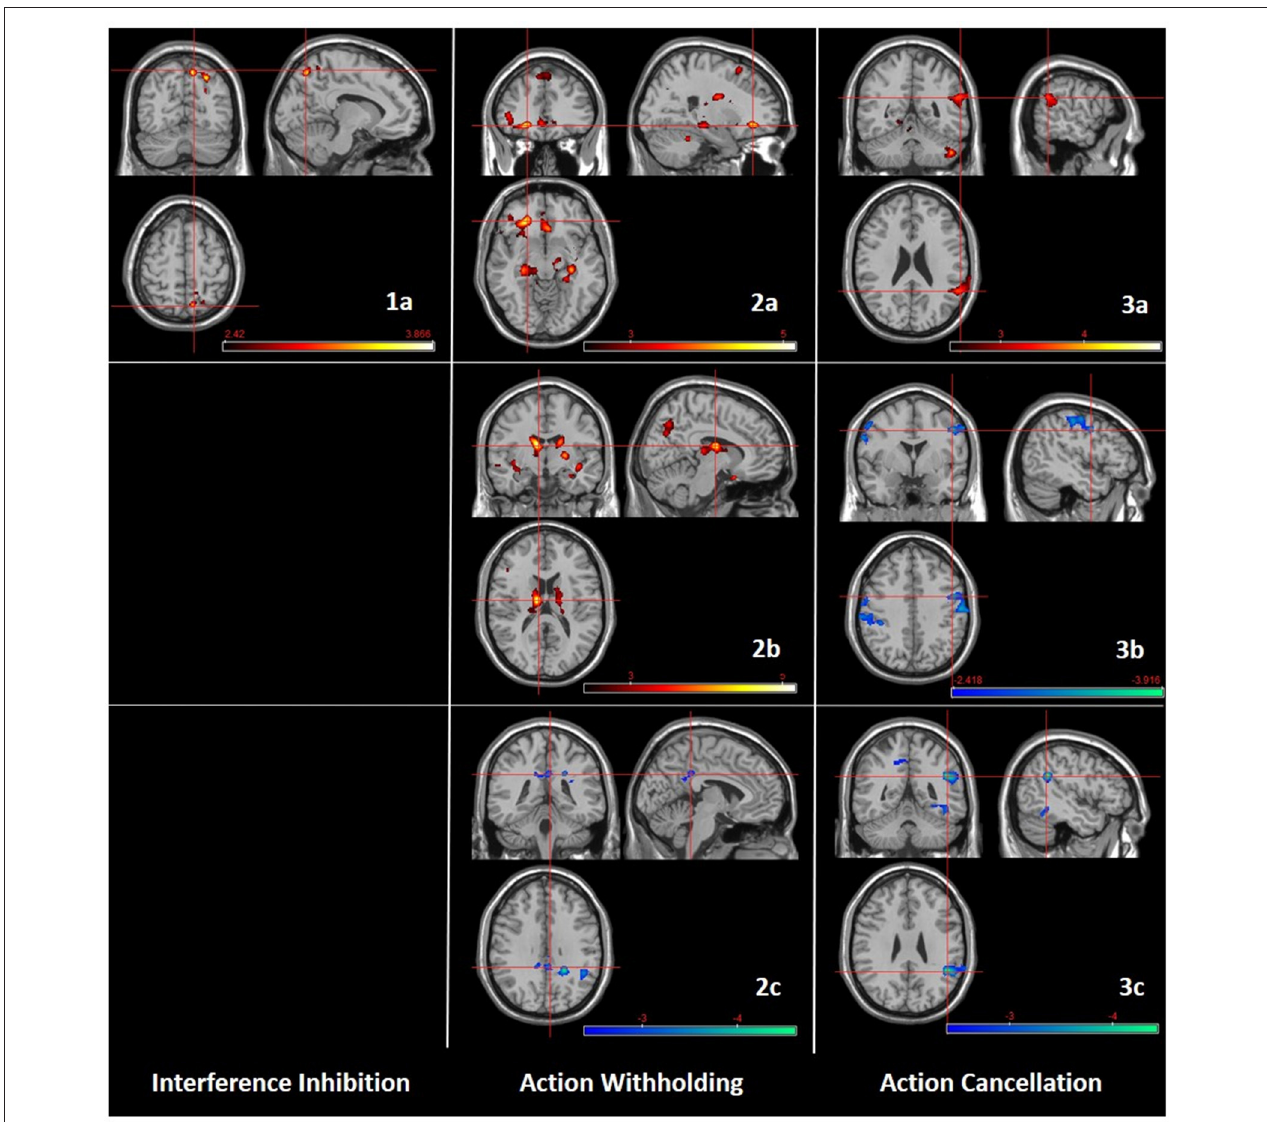
FIGURE 3 | Group comparisons (AUD, ADHD, HC) regarding subcomponents of response inhibition. Left: Interference inhibition; 1a: AUD > ADHD (10, − 68, 54). Middle: Action withholding; 2a: AUD > ADHD ( − 24, 36, − 10); 2b: AUD > HC ( − 10, − 10, 16); 2c: ADHD < HC (4, − 40, 32). Right: Action cancellation; 3a: AUD > ADHD (58, − 50, 24); 3b: AUD < HC (48, 0, 40); 3c: ADHD < HC (46, − 48, 28). CDT of P < 0.01 ( k ≥ 460). The color bar indicates t -scores, with red to yellow indicating a positive contrast and blue to green a negative contrast,